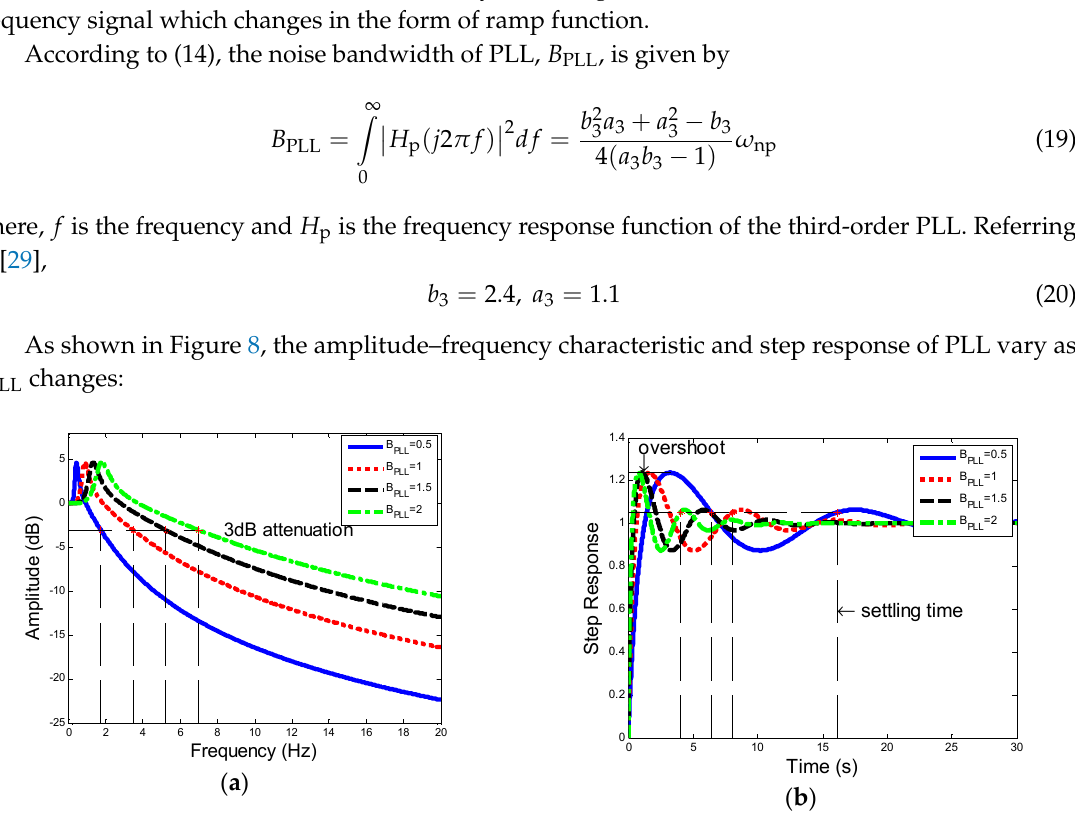
Figure 8. ( a ) Descriptions of amplitude–frequency characteristic. ( b ) Descriptions of step response of third-order PLL.